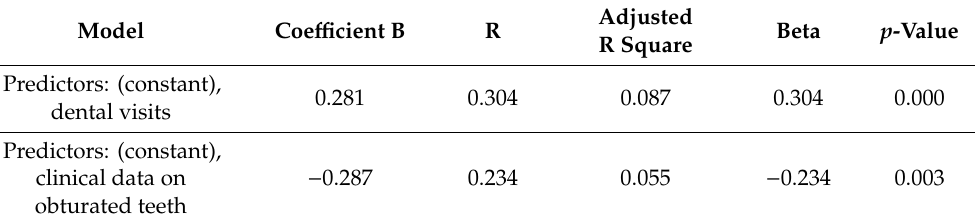
Table 3. Multivariate logistic regression.